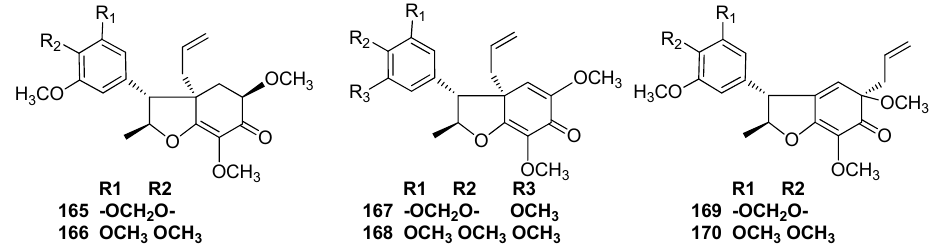
Figure 10. Chemical structures of 7,1’-neolignans.